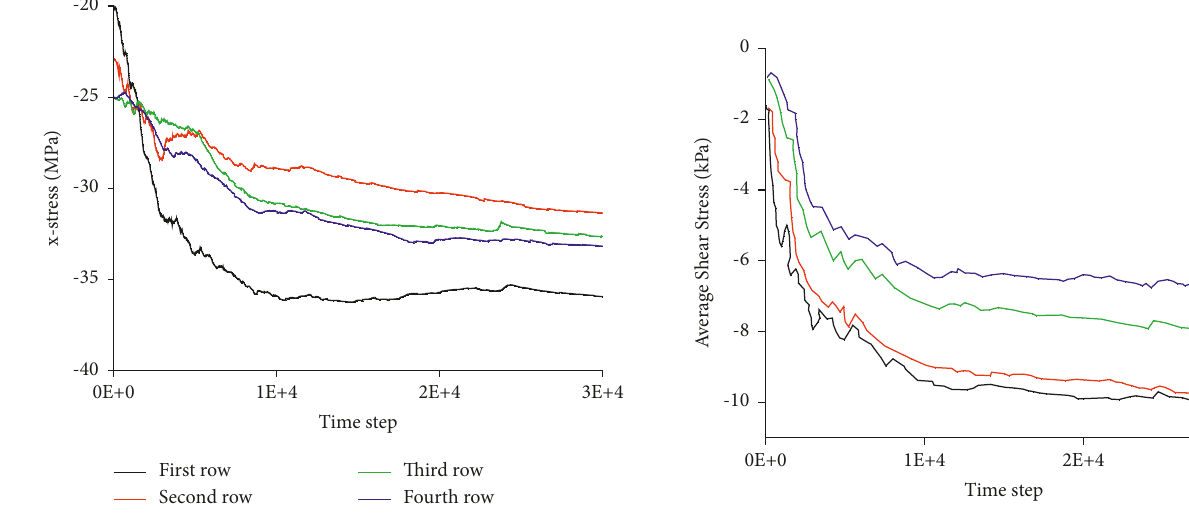
Figure 17: Lower average soil stress in the x -direction.